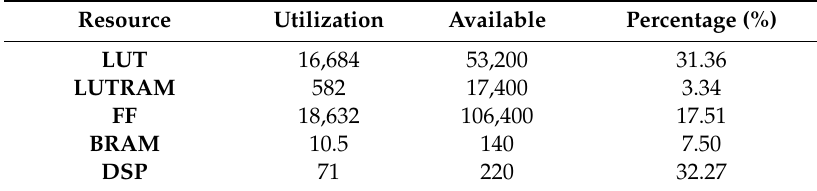
Figure 12. Resource utilization at different optimization levels. Table 4. Resource utilization at level ‘-O3’.